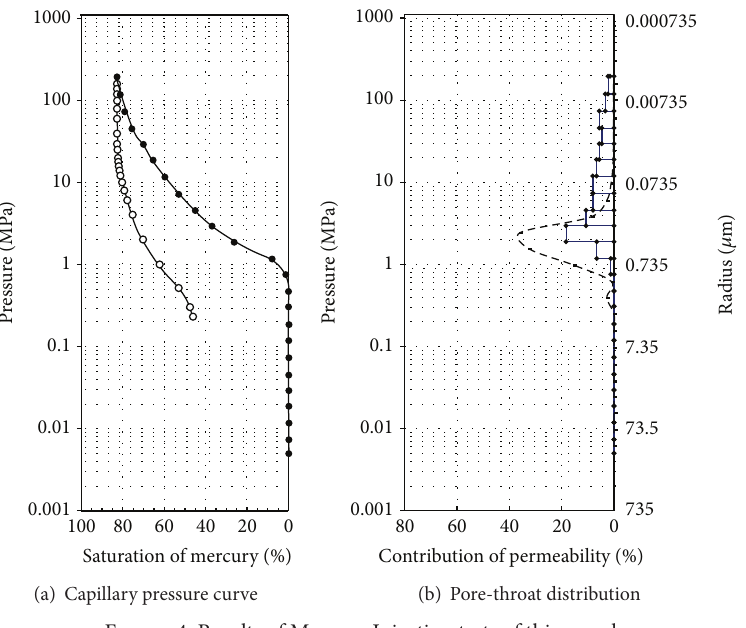
Figure 4: Results of Mercury Injection tests of this sample.